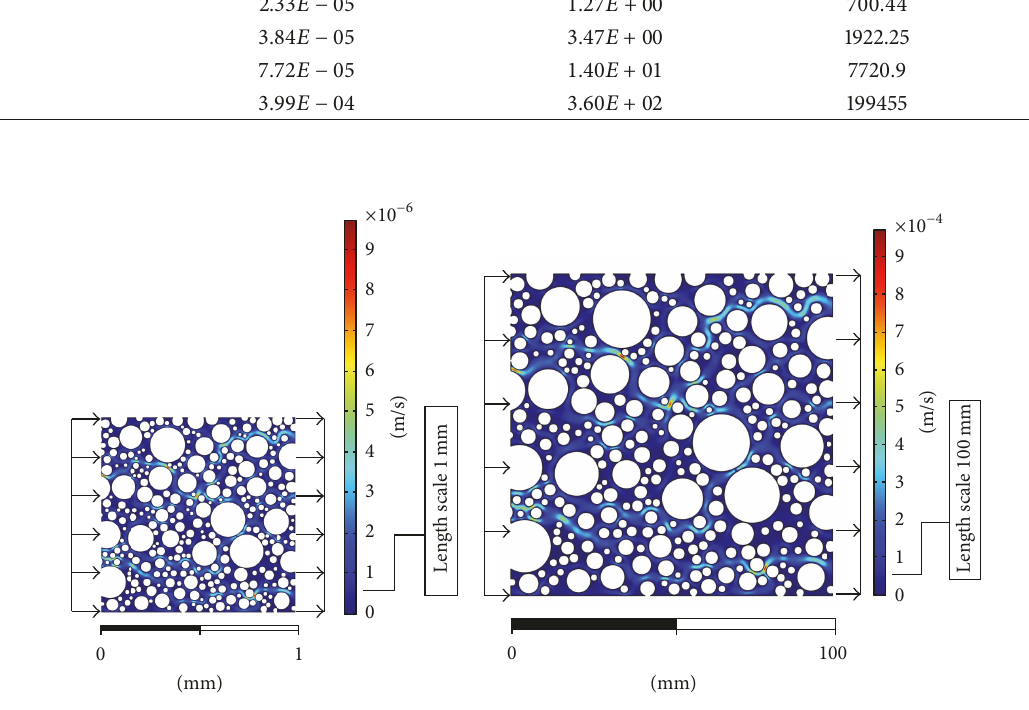
Figure 5: Velocity field in thermally shocked regions. 1mm and 100 mm domain length scale models are shown on (a) and (b), respectively. There are two orders of magnitude difference in the